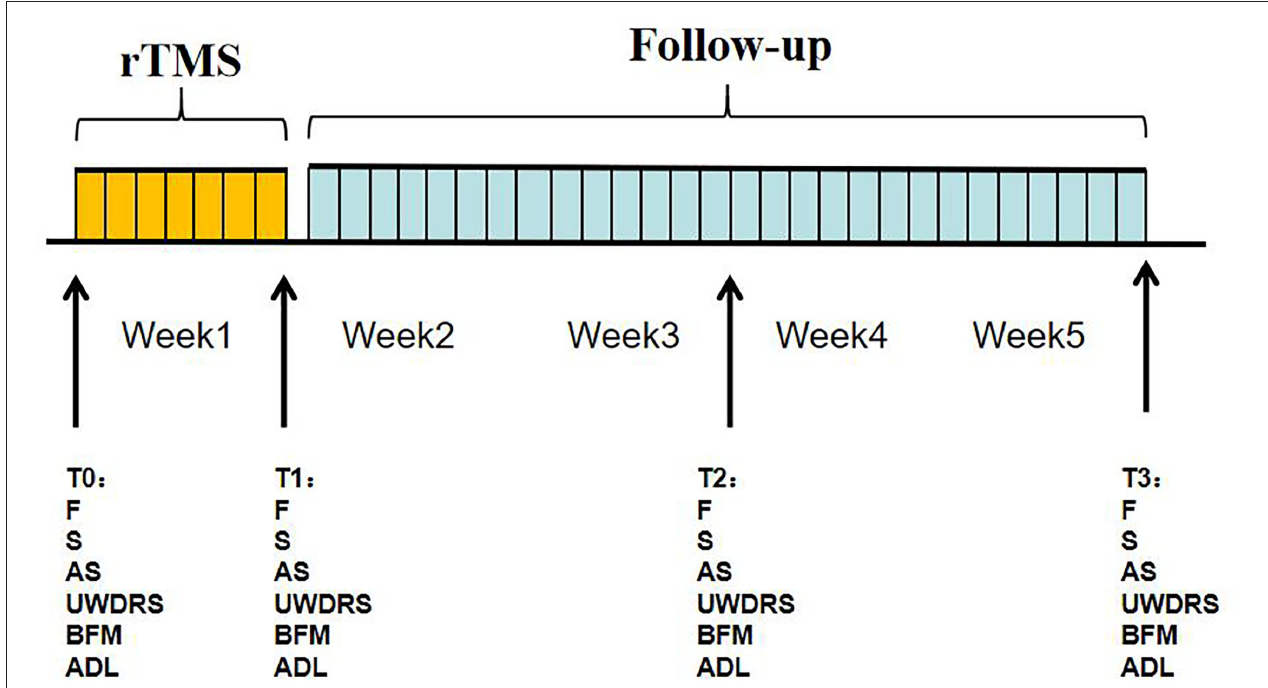
FIGURE 1 | Flow chart of the study